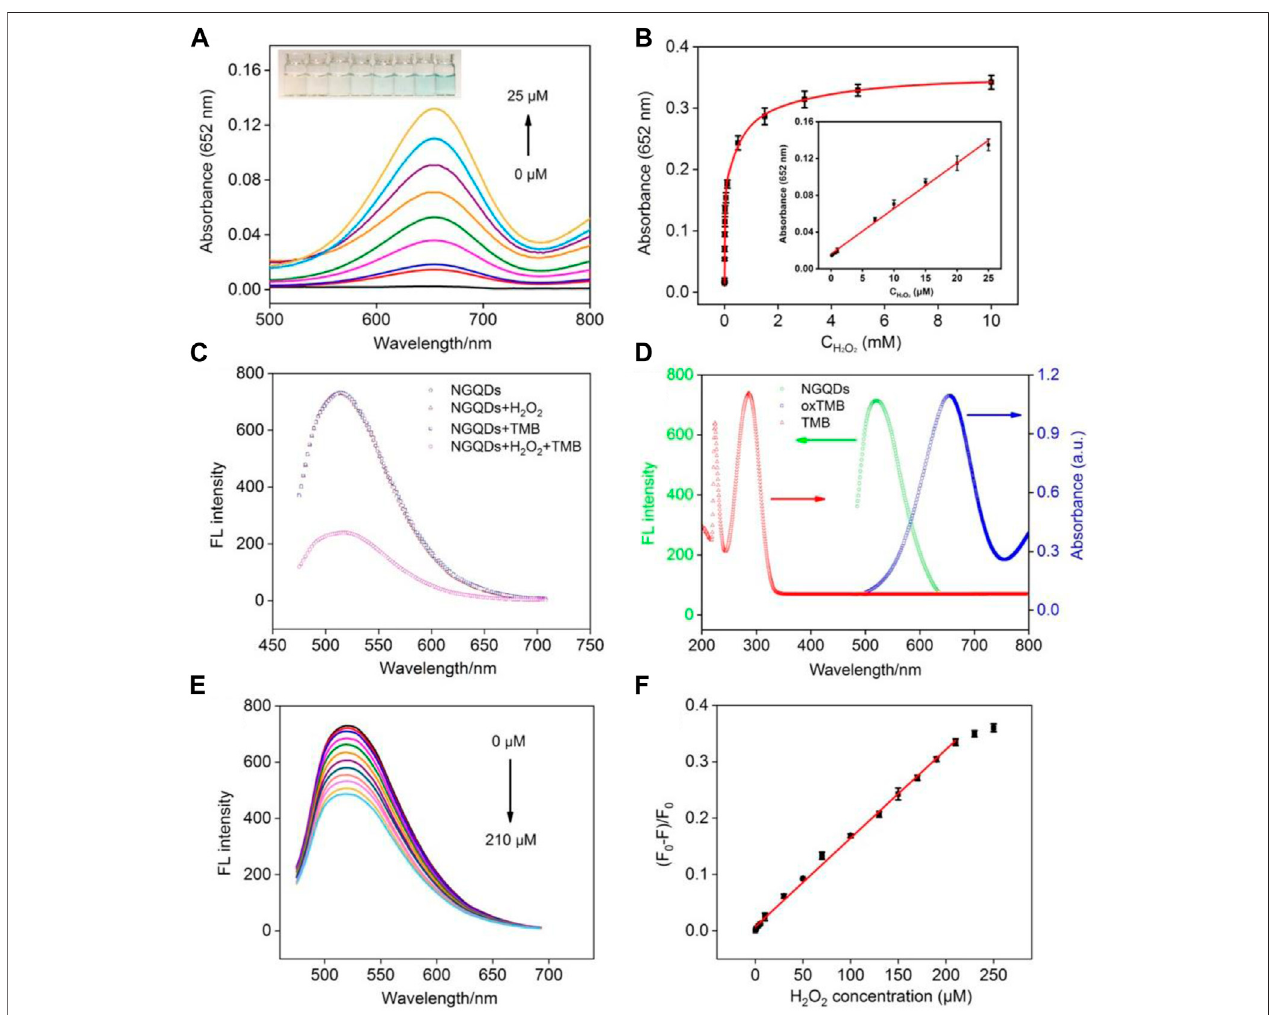
FIGURE6|(A) Absorbancespectraandphotographs(inset)obtainedfromthemixtureofNGQDsandTMBinthepresenceofdifferentconcentrationsofH 2 O 2 . (B) Change in absorbance at 652 nm with the increasing H 2 O 2 concentration. Inset is the linear calibration plot for colorimetric detection of H 2 O 2 . (C) The fl uorescence spectra of NGQDs in the absence or presence of H 2 O 2 , TMB, H 2 O 2 , or their combination. (D) Fluorescence spectrum of NGQDs and absorbance spectra of TMB or oxTMB. (E) Fluorescence spectra of NGQDs in TMB solution containing different concentrations of H 2 O 2 (0 – 210 μ M). (F) The linear calibration plot for fl uorescent detection of H 2 O 2